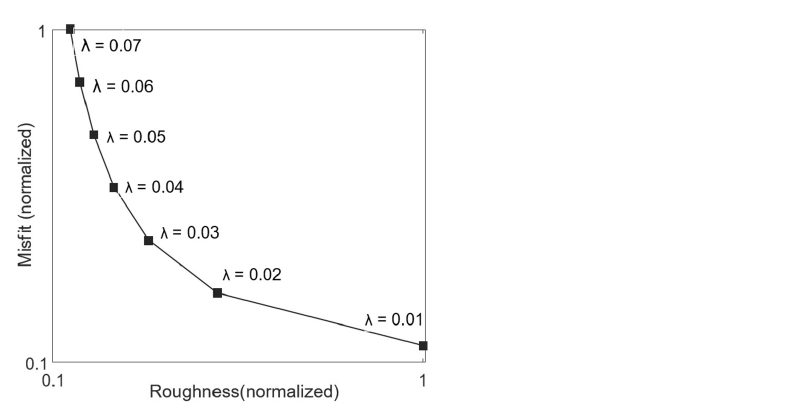
Figure 3. Trade-off curve between roughness and misfit. Both the roughness and misfit have been normalized.